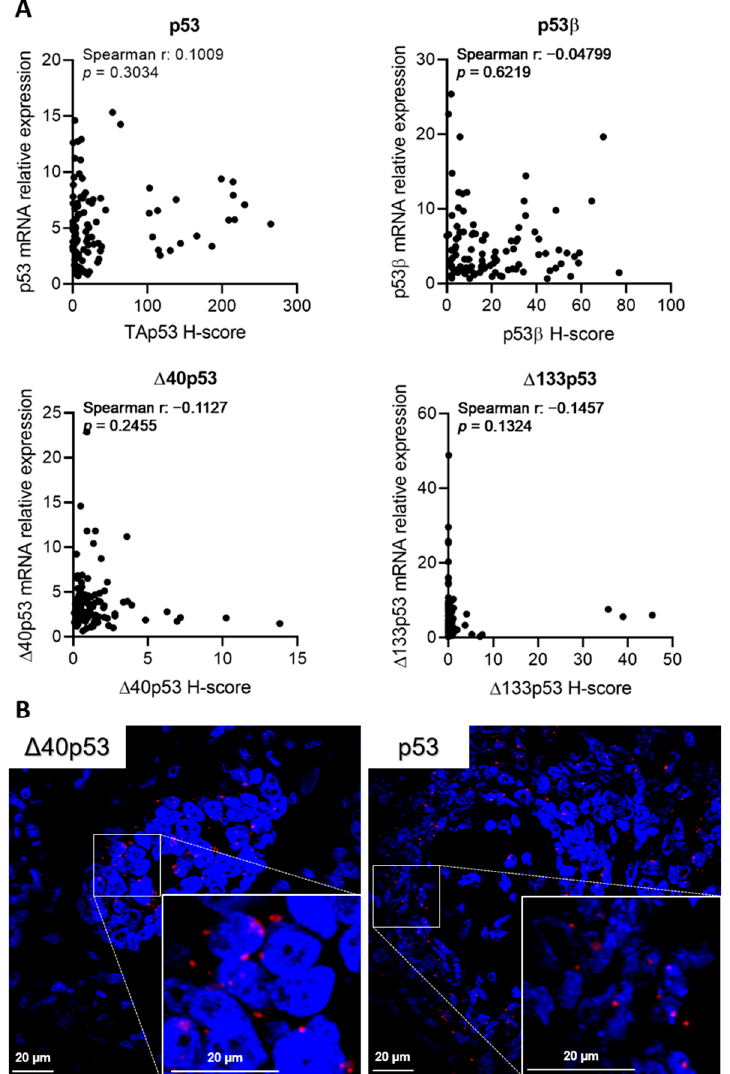
Figure 7. mRNA levels of p53 isoforms do not correlate with their protein expression levels. ( A ) Spearman rank correlation test was used to assess the correlation between mRNA data from our previous study [20] and protein levels (H-score) of p53, p53 β , Δ 40p53 and Δ 133p53 ( n = 108). ( B ) In situ hybridisation of a TNBC specimen for Δ 40p53 or TP53 (shown in red). Cell nuclei were stained with DAPI. Scale bar represents 20 µm.